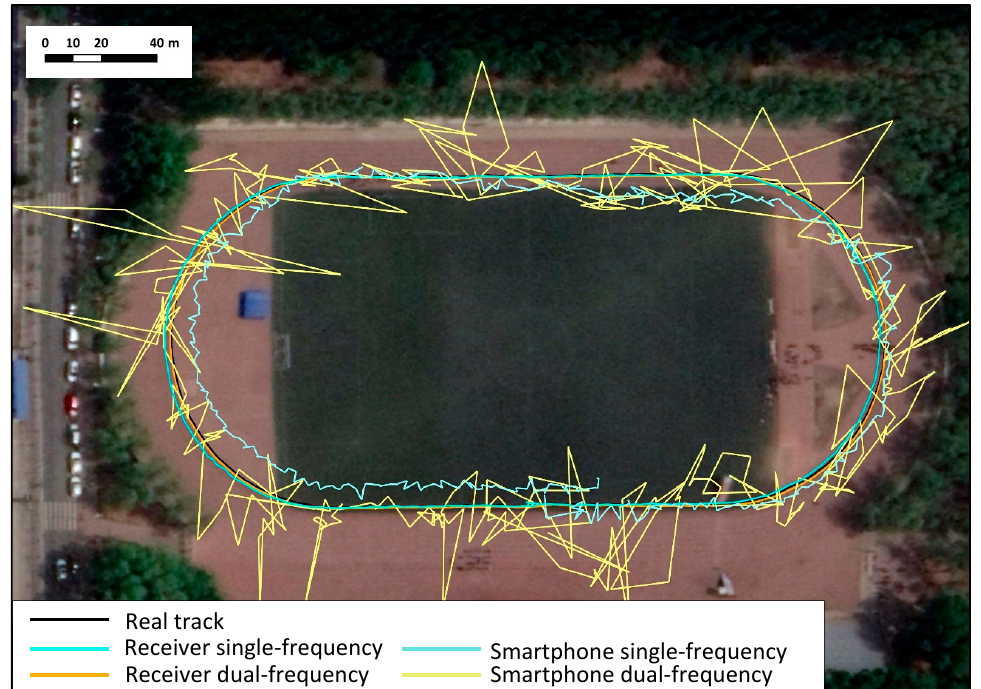
Figure 7. Kinematic positioning track in Google Earth.